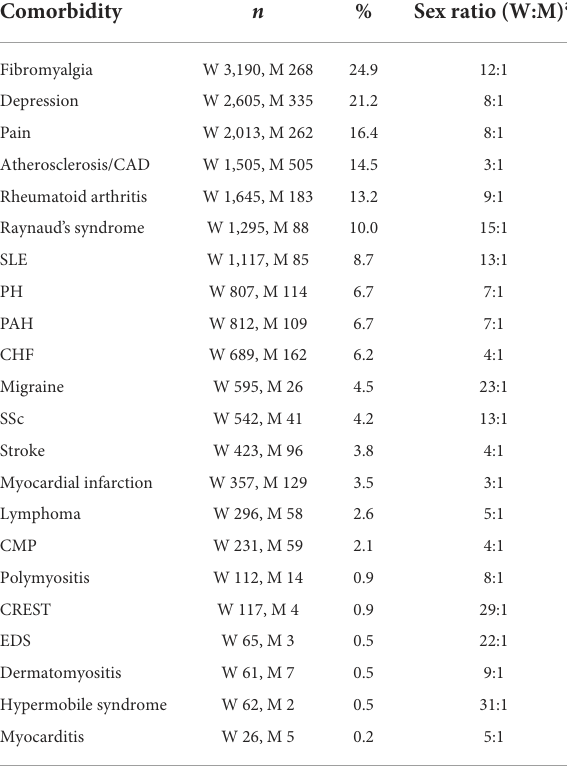
TABLE 9 Percentage and sex ratio of 22 comorbidities in women and men with Sjögren’s disease ( n = 13,849). Comorbidity n